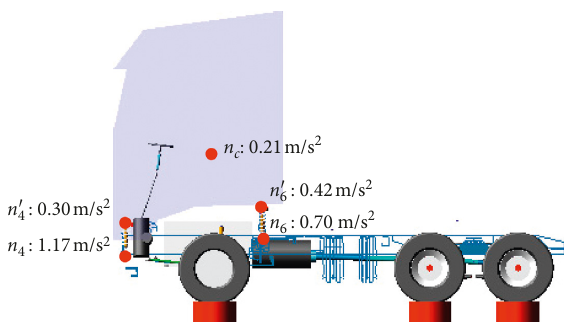
Figure 13: Vibration isolation rate of the engine three-point mount.